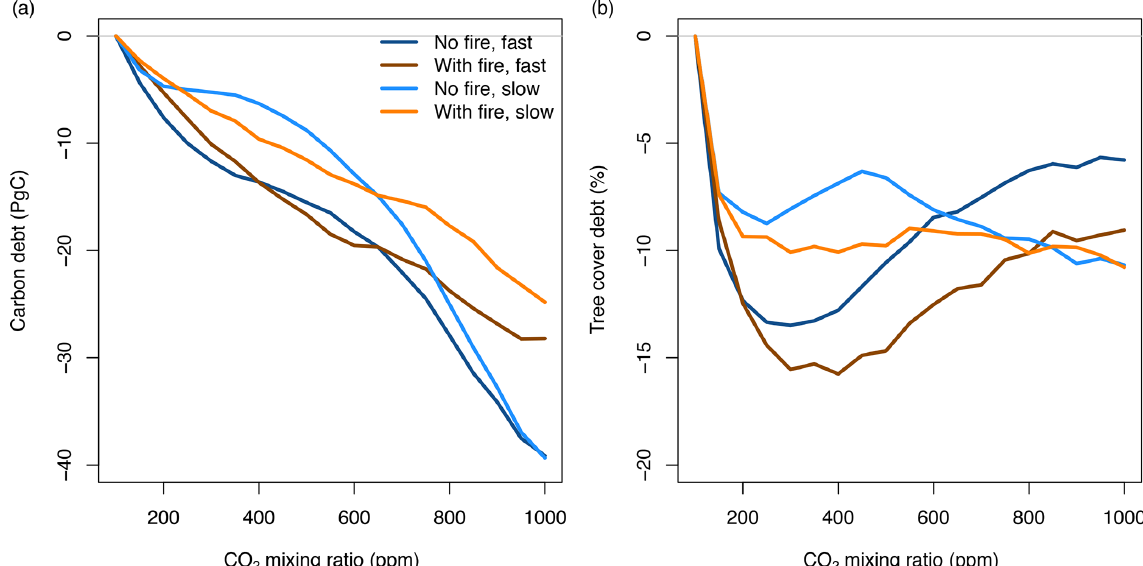
Figure 7. Debt of vegetation carbon and tree cover when the atmospheric CO 2 mixing ratio increases. Lines represent differences between transient and equilibrium simulations averaged for all study sites in Africa (simulated at 2 ◦ resolution). See Fig. S2 for decreasing CO 2 and associated tree cover and carbon surplus.